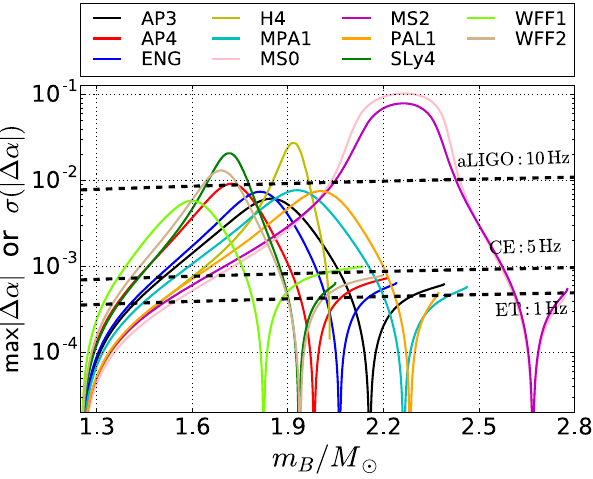
FIG. 7. The sensitivities of aLIGO, CE, and ET to j Δ α j [namely, the uncertainty σ ðj Δ α jÞ obtained from the inverse Fisher matrix] are depicted with dashed lines, as a function of m , for a B pattern-averaged BNS inspiral signal with rest-frame component 1 . 25 M masses ( m ⊙ , m B ). The starting frequencies of GW A ¼ 200 Mpc is ffiffiffiffiffiffiffiffiffiffiffiffiffiffi p detectors are labeled. Luminosity distance D L ¼ fS f Þ of assumed. The sensitivity to j Δ α j from GW detectors scales with n ð f Þ is the SNR as ρ − 1 = 2 . The maximum available values of j Δ α j for 11 n ð EOSs, saturating the limits from binary pulsars at 90% C.L., are f Þ ≡ shown as solid lines. If a sensitivity curve (dashed) is below a c ð 1 . 63 M solid curve, the corresponding GW detector has the potential to ⊙ ; ⊙ Þ improve the limit from binary pulsars for this particular EOS, with BNSs of suitable